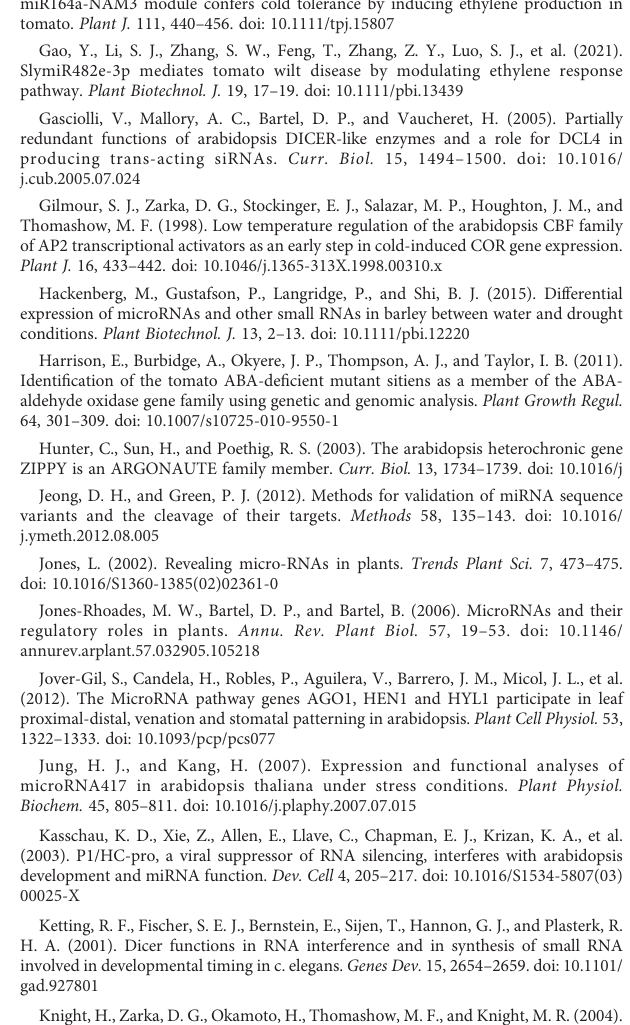
Promoter cis-acting elements analysis of DCL1-cleaved miRNAs target genes.